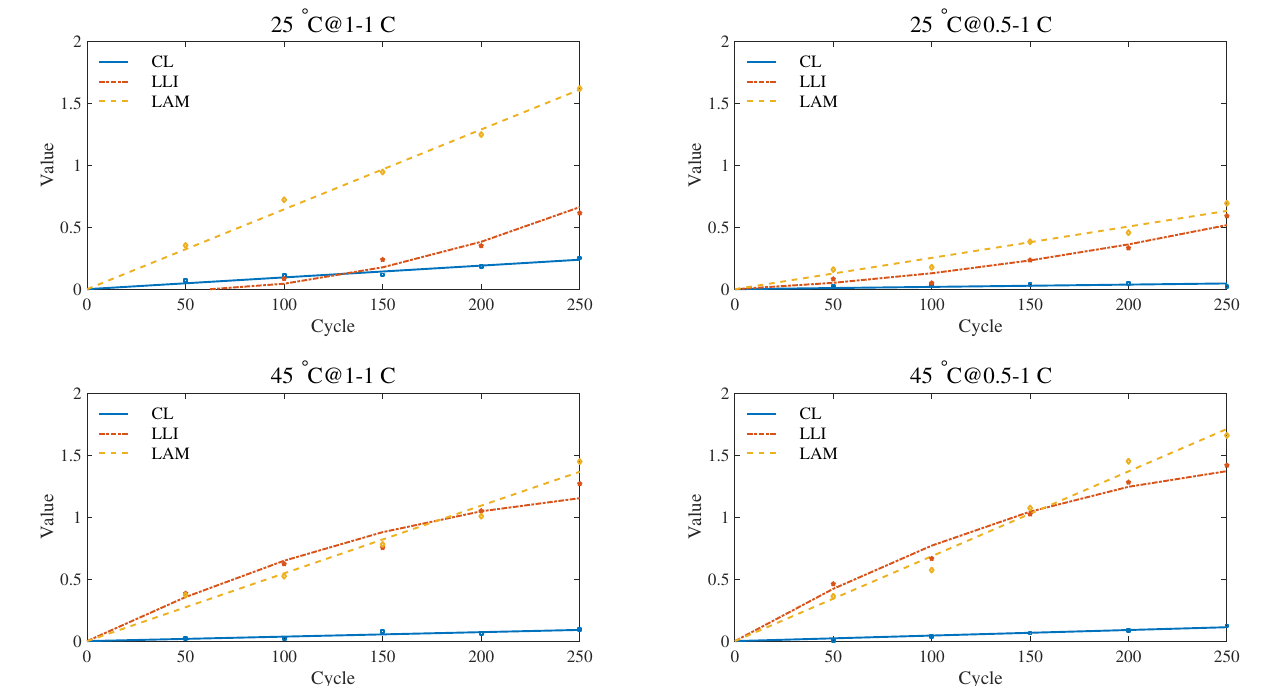
Figure 10. Quantitative results of degradation modes of lithium-ion batteries under different conditions, using 500 mA current excitation and 20% SoC for EIS measurement.